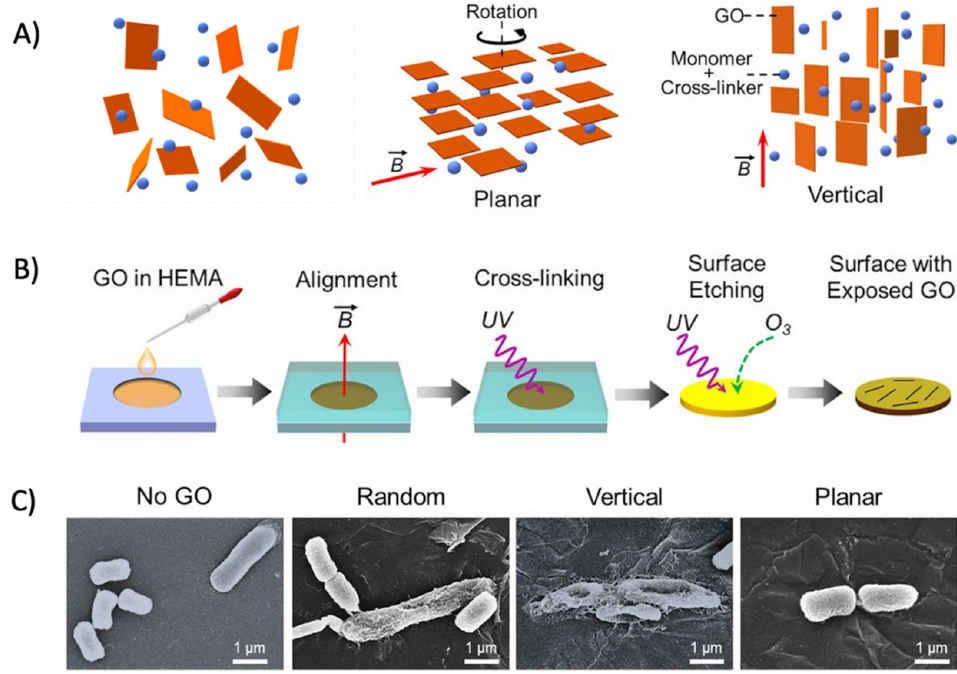
Figure 9. ( A ) Schematic illustration of the GO film with different orientations. From left to right: random, planar, and vertical orientations. ( B ) Schematic illustration of the film fabrication procedure. A magnetic field is applied to control the orientation of dispersed GO nanosheets, with the orientation preserved by photo-cross-linking the dispersing agents. ( C ) SEM micrographs pictured the intact E. coli morphology treated by no-GO film, retained E. coli morphological integrity treated by randomly aligned- or planar aligned-GO film and flattened and wrinkled E. coli morphologies after being treated by a vertically aligned-GO film. (Adapted with permission from Ref. [335]. 2017, Lu et al. More details on “Copyright and Licensing” are available via the following link: https://www.mdpi.com/ethics#10 (accessed on 10 October